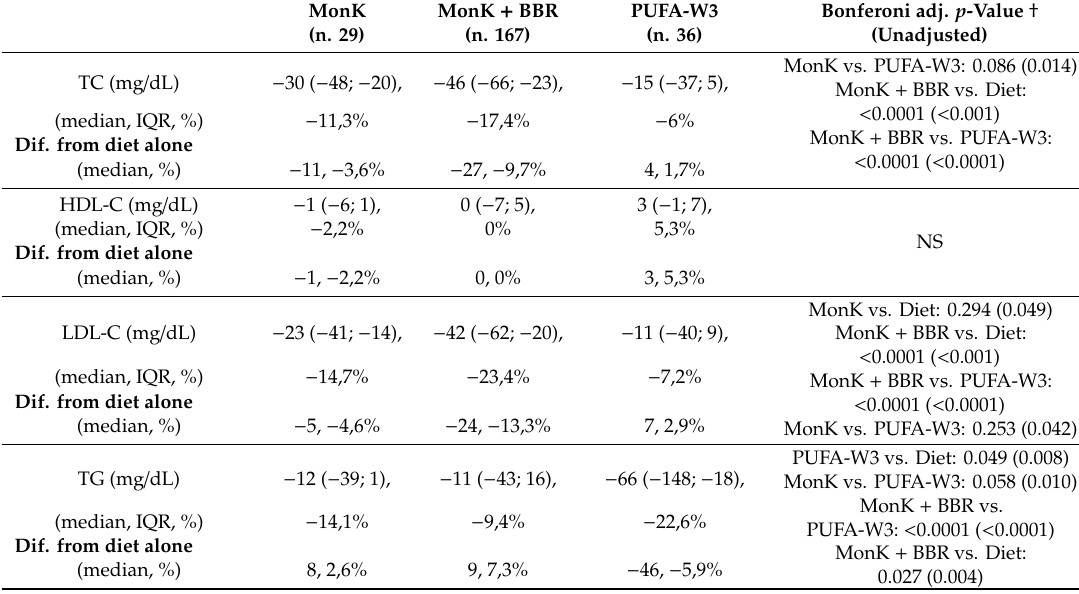
Table 3. E ff ect of di ff erent groups of NUTs on lipid profile and comparison with diet alone by the di ff erence in the